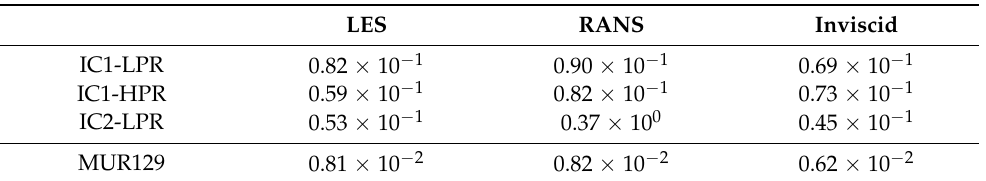
Table 4. Mass-weighted averaged loss coefficient at ( x coordinate) for various operating conditions and flow